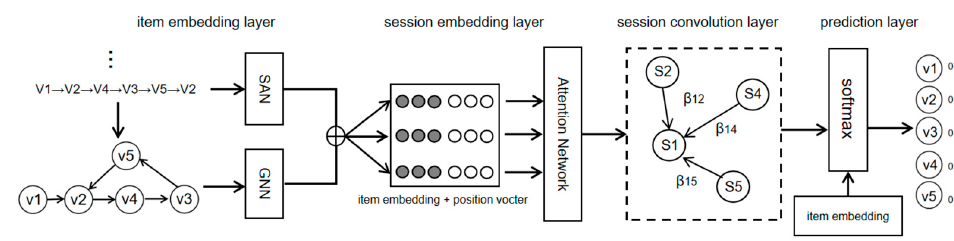
Figure 1. The detailed structure of SE-GNNRM.